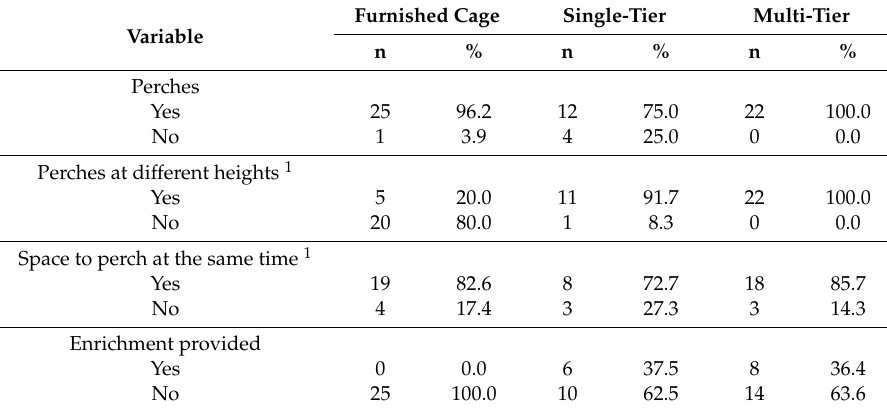
Figure 1. Boxplot of group size (number of hens) and space allowance (cm 2 /hen) for 65 laying hen flocks placed between October 2016 and December 2017 according to housing system (furnished cage n = 26, single-tier n = 17, multi-tier n = 22) in Canada. Table 2. Distribution of perches and enrichment provision for 65 laying hen flocks placed between October 2016 and December 2017 according to housing system (furnished cage n = 26, single-tier n = 17, multi-tier n = 22) in